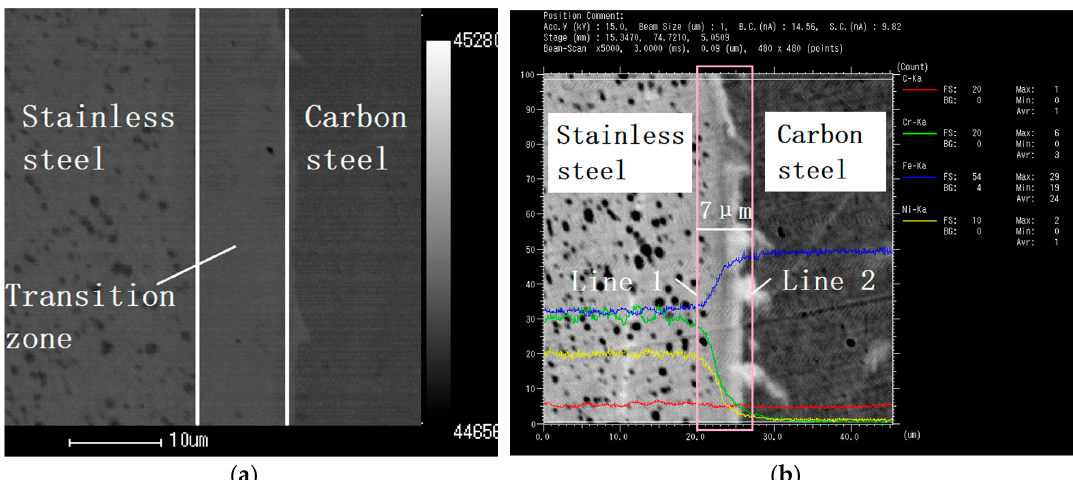
Figure 2. Metallographic microscope observation of the transition layer: ( a ) Metallographic micrograph (5000×); ( b ) electron probe microanalysis (5000×).